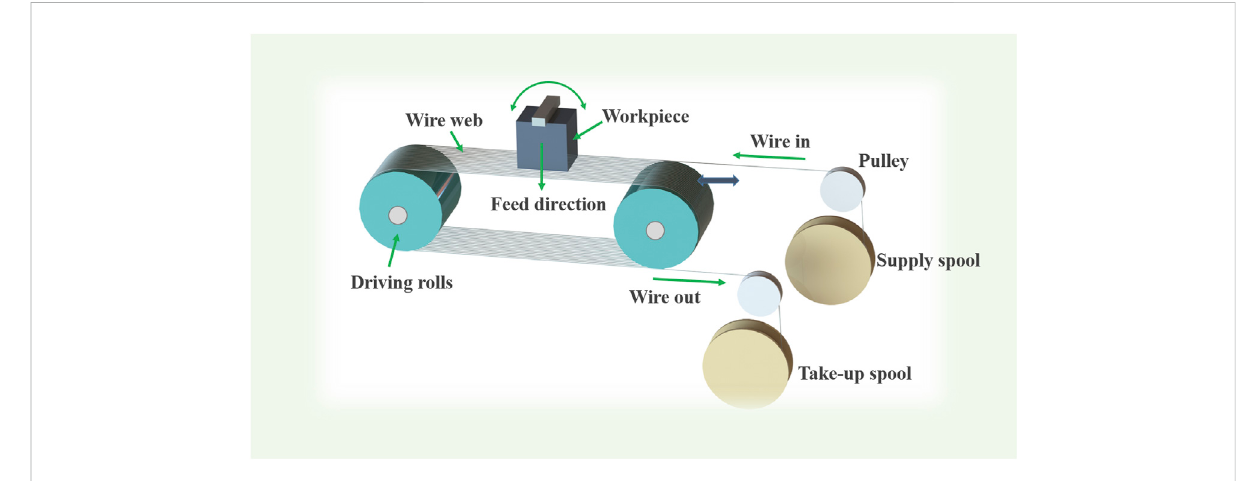
FIGURE 1 The schematic of multi-wire saw cutting.